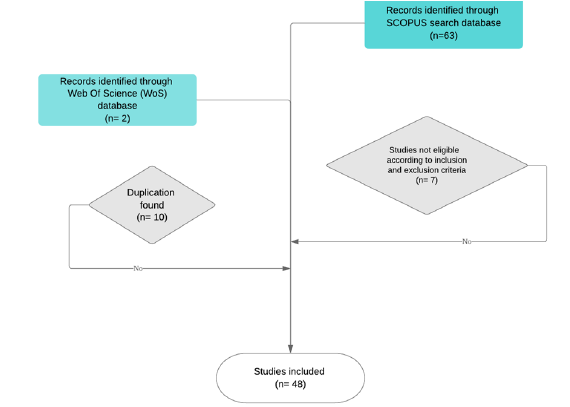
Fig. 1. Inclusion and exclusion criteria in the thematic review. Adopted from